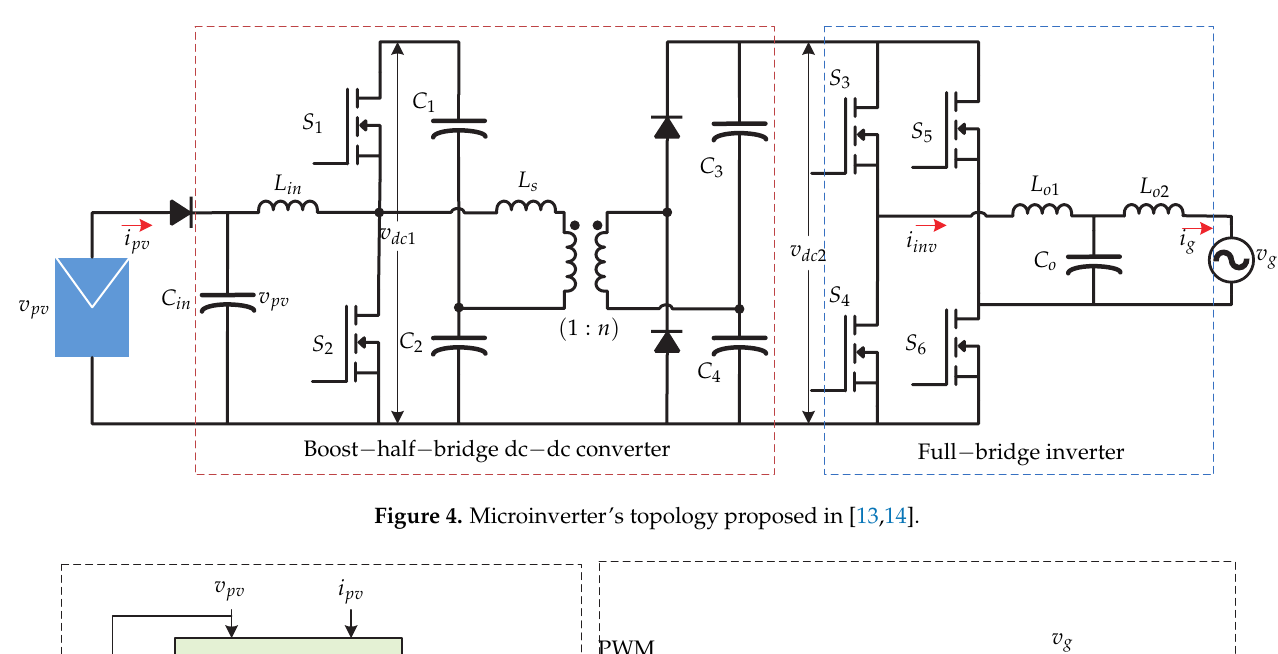
Figure 4. Microinverter’s topology proposed in [13,14].